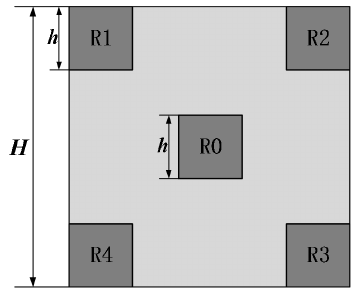
Figure 3. Template for local